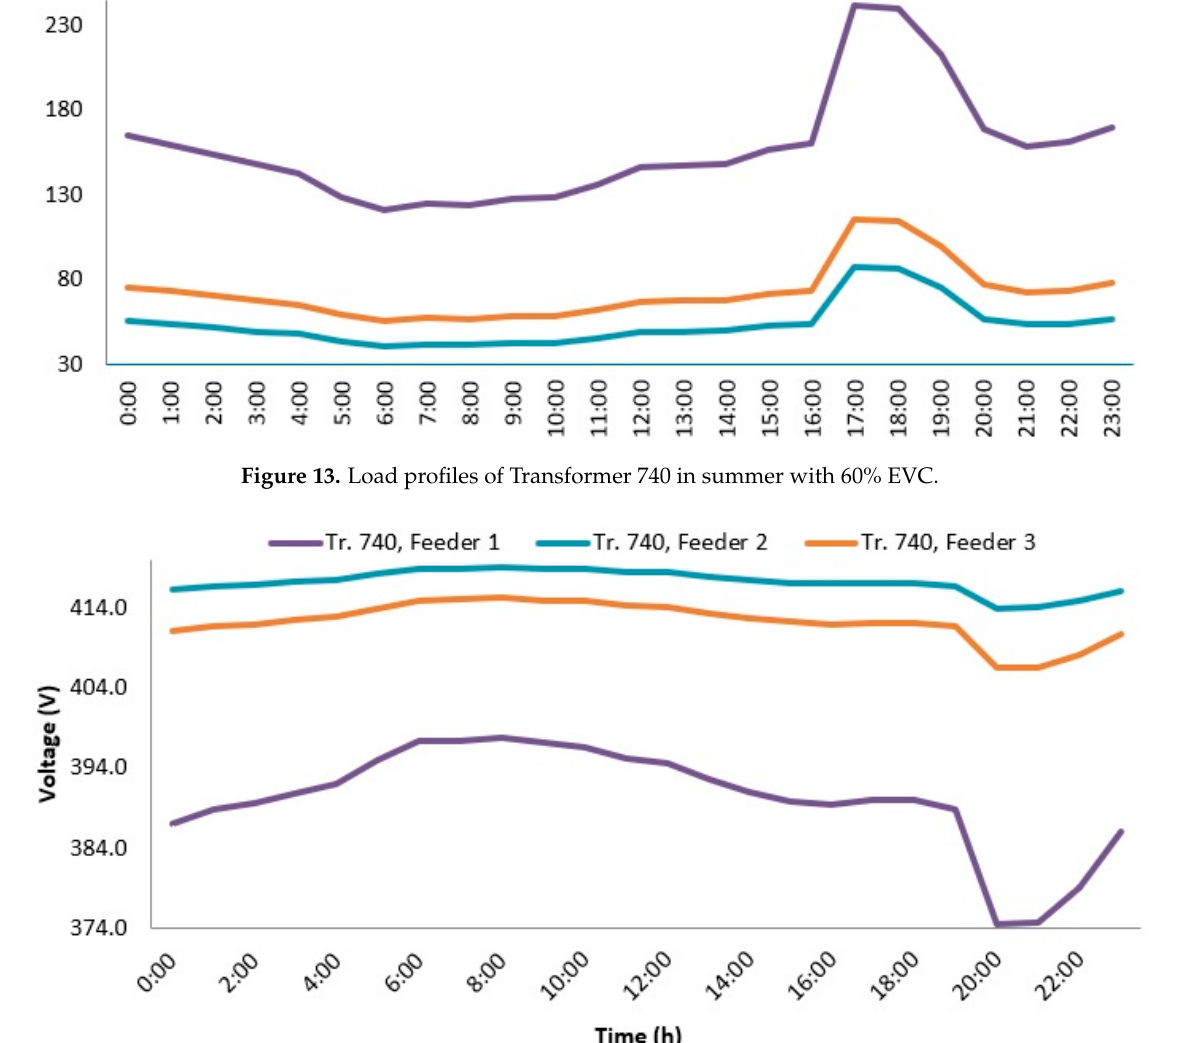
Table 7. Loading of the LV network in summer with 0%, 40%, and 60% EVC and different charging schemes.